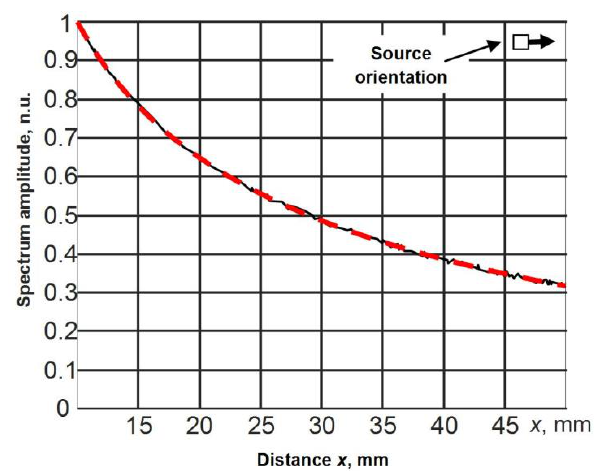
Figure 4. Dependence of spectrum amplitude at 44 kHz on the distance from the point type 1 × 1 mm 2 excitation point. Solid line — finite element modelling data, dashed line — curve fitting.